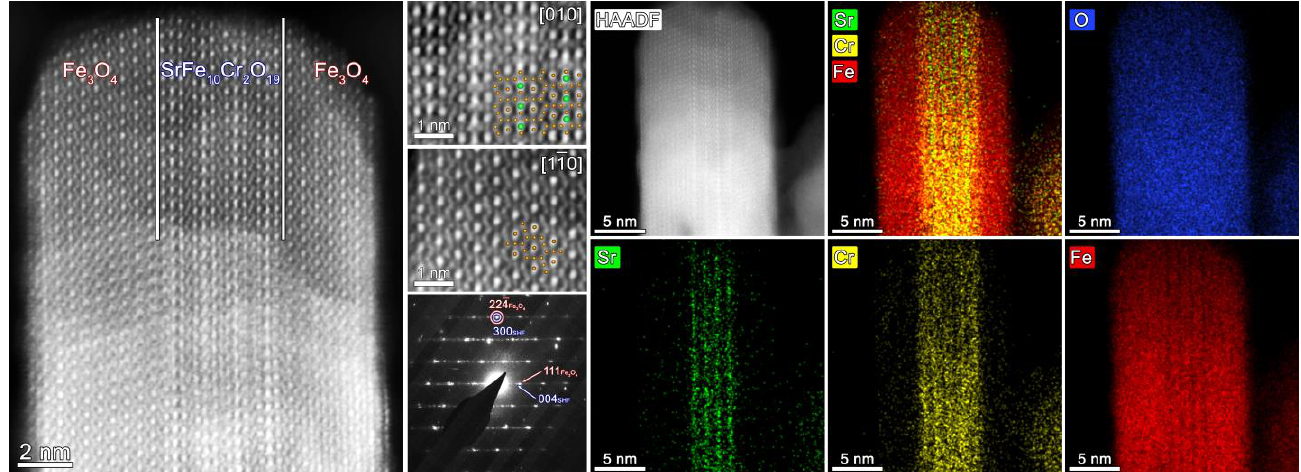
Figure 3. High-resolution HAADF STEM images: overall view of the Fe 3 O 4 /SrFe 10 Cr 2 O 19 /Fe 3 O 4 composite sample FO_11; inner hexaferrite and outer spinel parts (green balls represent Sr, brown— Fe/Cr), SAED pattern of the area. At the right part of the collage HAADF-STEM image of the composite particle and color-coded EDX elemental (Sr, Cr, Fe, O) maps are presented.